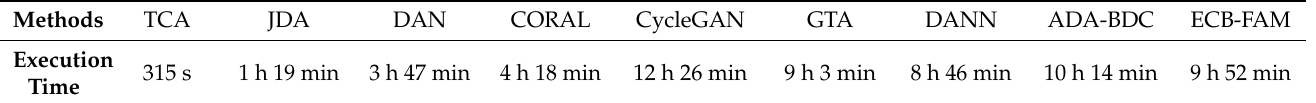
Table 5. Execution time of the proposed framework as compared with the baseline